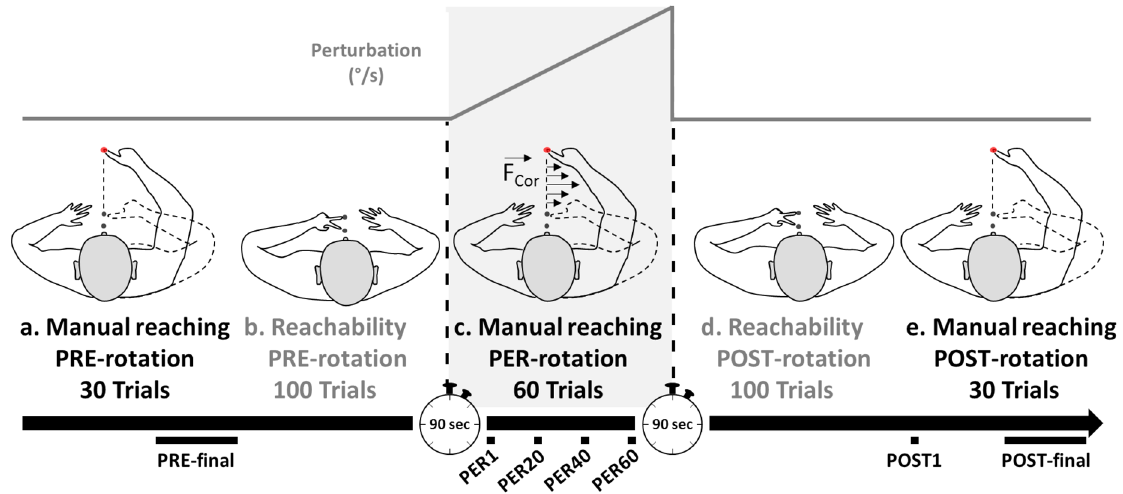
Figure 2. Illustration of the experimental procedure. Manual reaching performance was assessed before ( a ), during ( c ) and after ( e ) platform rotation, while reachability was estimated just before ( b ) and just after ( d ) platform rotation. Rotating speed was gradually increased by increments of 2°/s, from 0°/s to a maximum of 120°/s, over the series of 60 trials during the PER-rotation phase. The expected direction and magnitude of the velocity-dependent Coriolis force are illustrated on ( c ). At the bottom of the Figure, the manual reaching trials used for statistical analyses are shown under the black time arrow: the ten last trials before rotation (PRE-final), the first (PER1) and every twentieth trial (PER-20, 40 and 60) during rotation, and the first (POST1) and ten last trials (POST-final) after